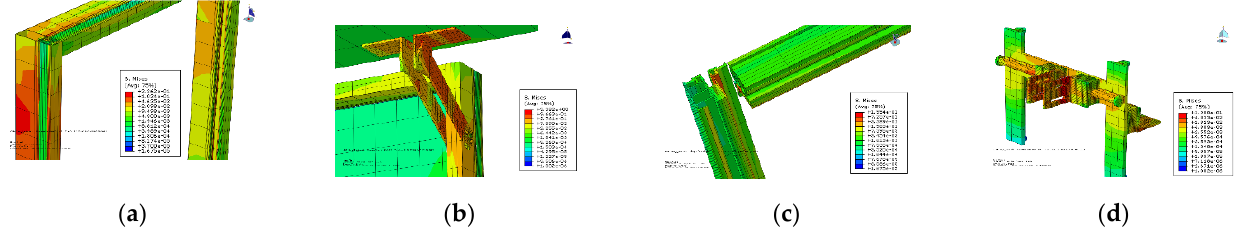
Figure 23. Stress distribution in each member of seismic curtain wall during X -axis drift: ( a ) aluminum; ( b ) upper kicker; ( c ) PVC; ( d ) linear guide-to-fastener connection part.